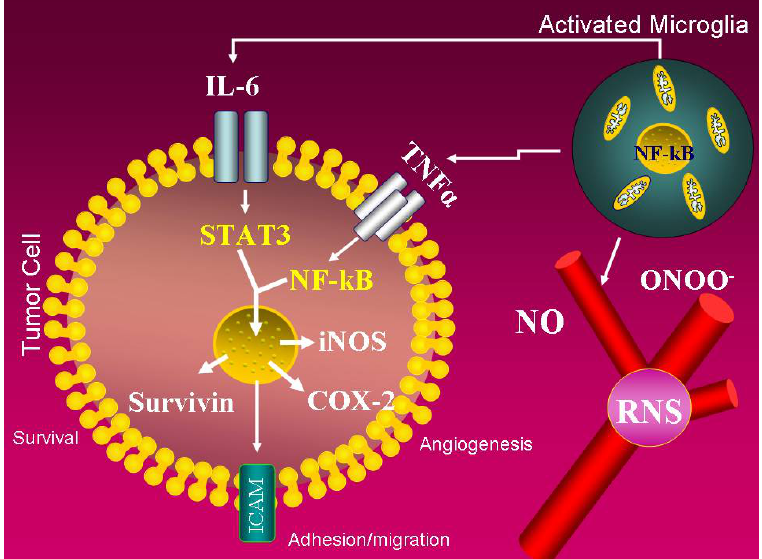
Figure 3. Possible IL-6-mediated paracrine activation of glioma cells. Schematic drawing describing the hypothesis that inflammatory cells, such as activated macrophage/microglial cells, synthesize IL-6 through NF- κ B. As a consequence, glioma cells, particularly tumor stem cells, are activated by IL-6 via paracrine stimulation. Chemokines, including IL-6 and TNF α , activate the transcription factors STAT3 and NF- κ B that, in turn, initiate specific pathways for tumor progression such as angiogenesis, migration, and apoptosis